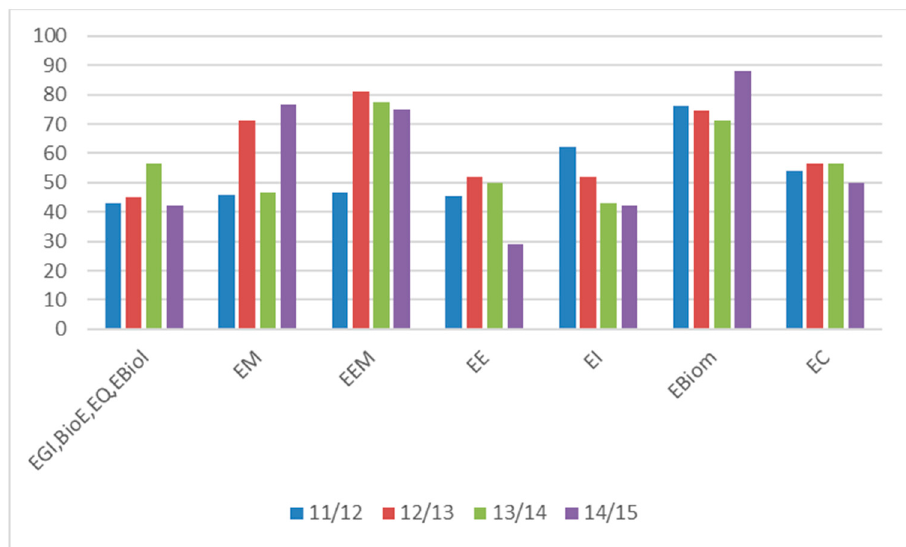
Figure 5. Pass rate distribution for the 1st semester of the academic years 2011/2012 to 2014/2015 and all undergraduate degrees in ISEC.